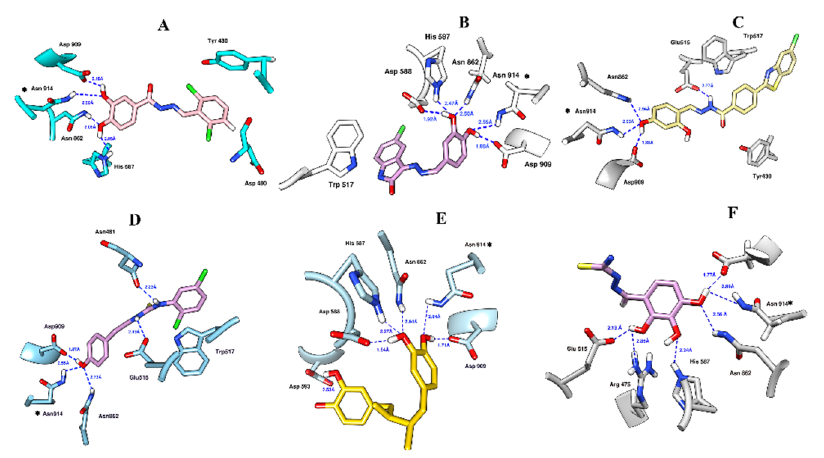
Figure 3 . The 3D interactions of the selected hits ( A ) A3898 (pink), ( B ) A3566 (purple), ( C ) A6996